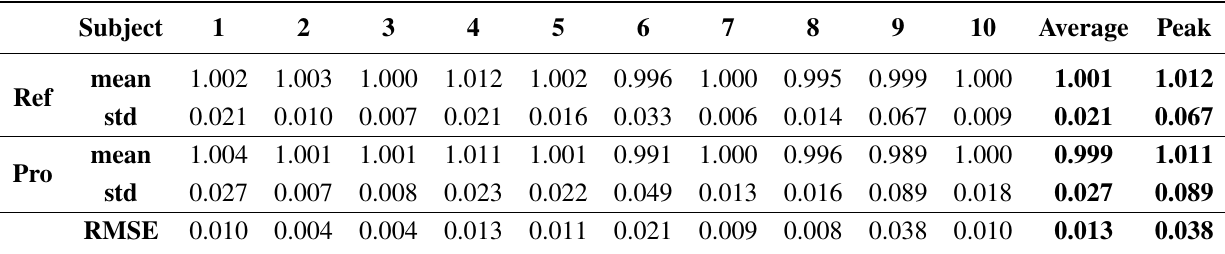
Table 5. Mean and standard deviation of the reference (Ref) and proposed (Pro) systems and RMSE in detecting horizontal stride symmetry (hS) for each subject. Averaged values across the ten subjects are also reported.